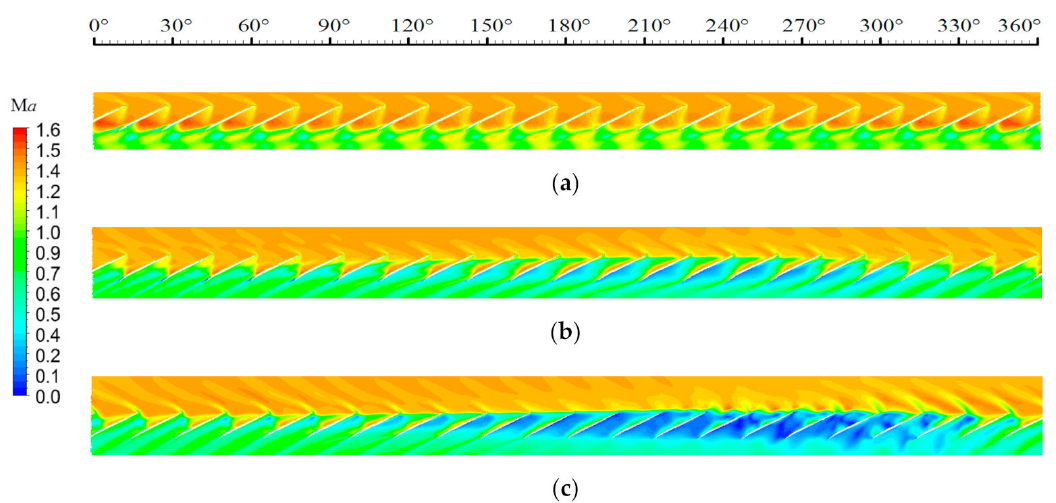
Figure 18. The circumferential distribution of the blade tip Mach number calculated by unsteady CFD under di ff erent working conditions at E = 160%. ( a ) NC; ( b ) NPE; ( c ) NS.